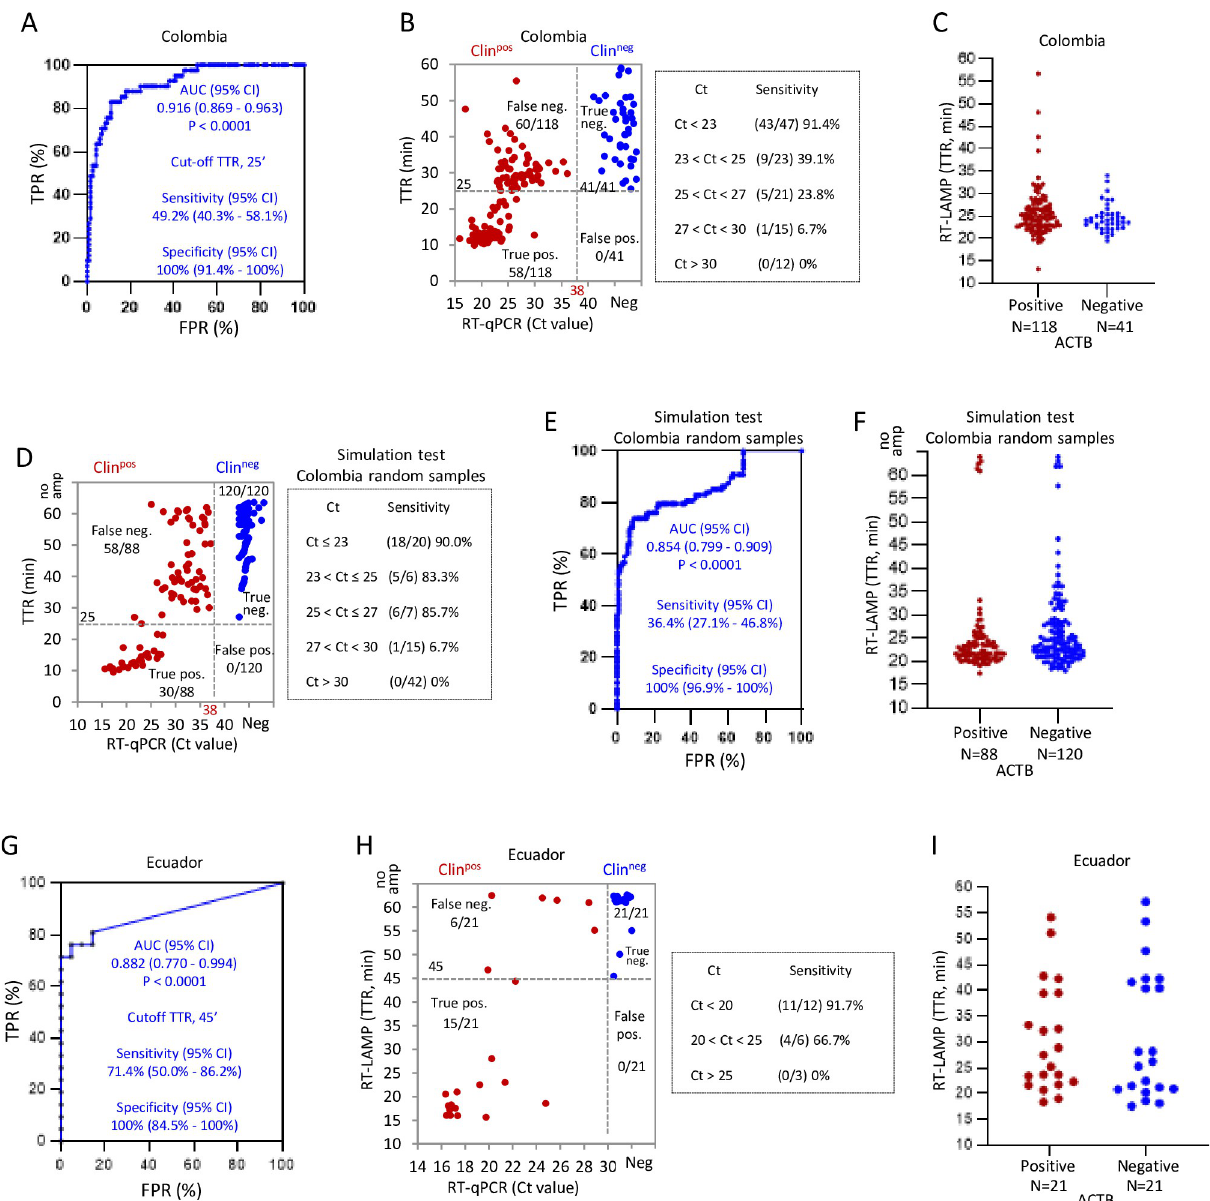
Fig 6. Direct RT-LAMP on raw clinical NP samples of Colombia and Ecuador. (A) ROC curve evaluating the optimized direct RT-LAMP performance on 118 positive and 41 negative clinical NP samples from Colombia. (B) Distribution of the RT-LAMP TTRs vs. U-TOP Seasun RT-PCR Ct values for Orf1ab, and the sensitivity of RT-LAMP at the indicated Ct intervals with samples in (A). (C) Distribution of ACTB TTRs of samples in (A). (D) Plot of TTRs vs . Ct values in a simulation RT-LAMP test with randomly chosen Colombian samples, and the sensitivity at the indicated Ct intervals with these samples. (E) ROC curve analysis validating the simulation RT-LAMP test in (D). (F) Distribution of ACTB TTRs of samples in (D). (G) ROC curve analysis of the direct RT-LAMP with 21 positive and 21 negative NP samples of Ecuador. (H) Distribution of the direct RT-LAMP TTRs vs . RT-PCR Ct values for E gene, and the sensitivity at the indicated Ct values for samples in (G). (I) Distributions of ACTB TTRs of samples in (G). Dotted lines in distribution graphs indicate cutoffs.